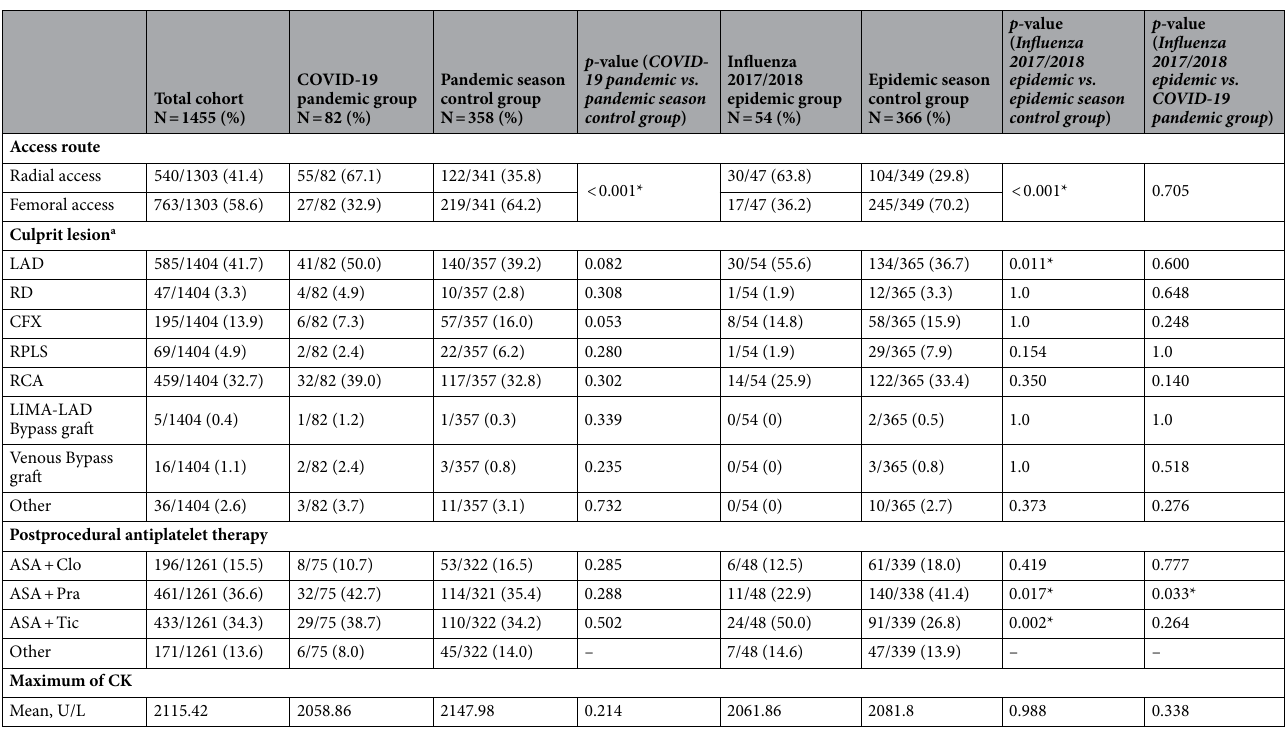
Table 3. Periprocedural characteristics. LAD left artery descending, RD diagonal branch, CFX circumflex artery, RPLS posterolateral artery branch, RCA right coronary artery, LIMA left internal mammary artery,